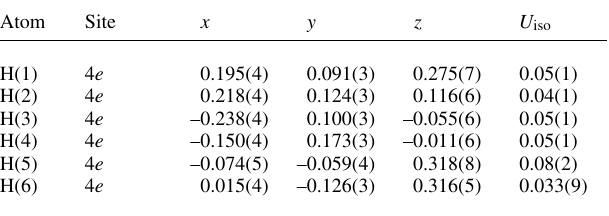
Table 7. Data collection and handling. Table 8. Atomic coordinates and displacement parameters (in Å 2 ) .